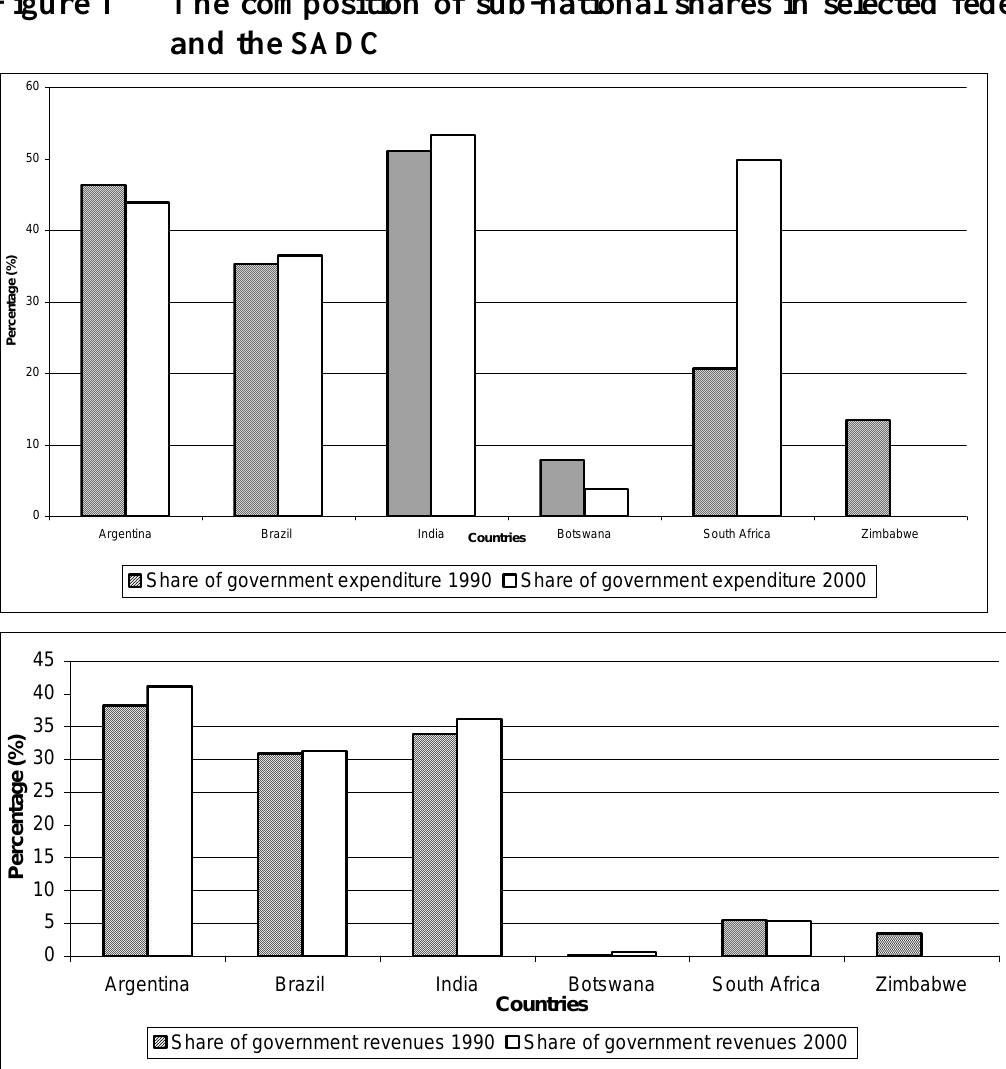
Figure 1 The composition of sub-national shares in selected federations and the